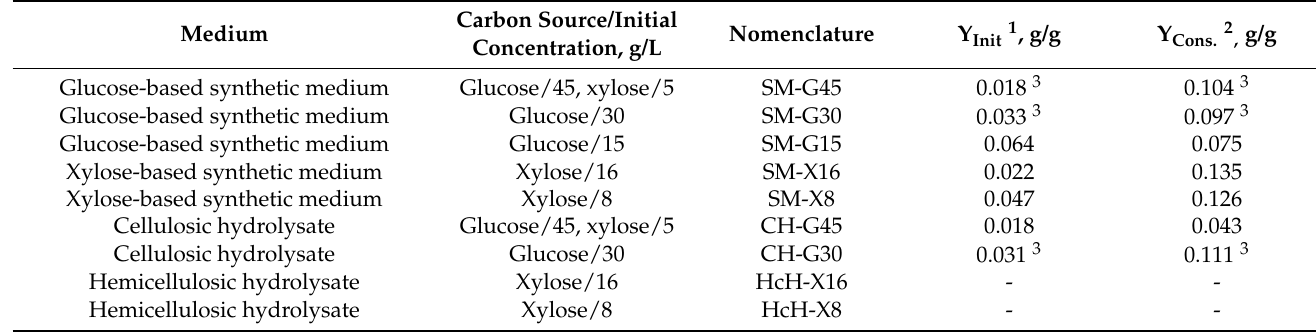
Table 3. Summary of the used media and achieved EPS yield in the